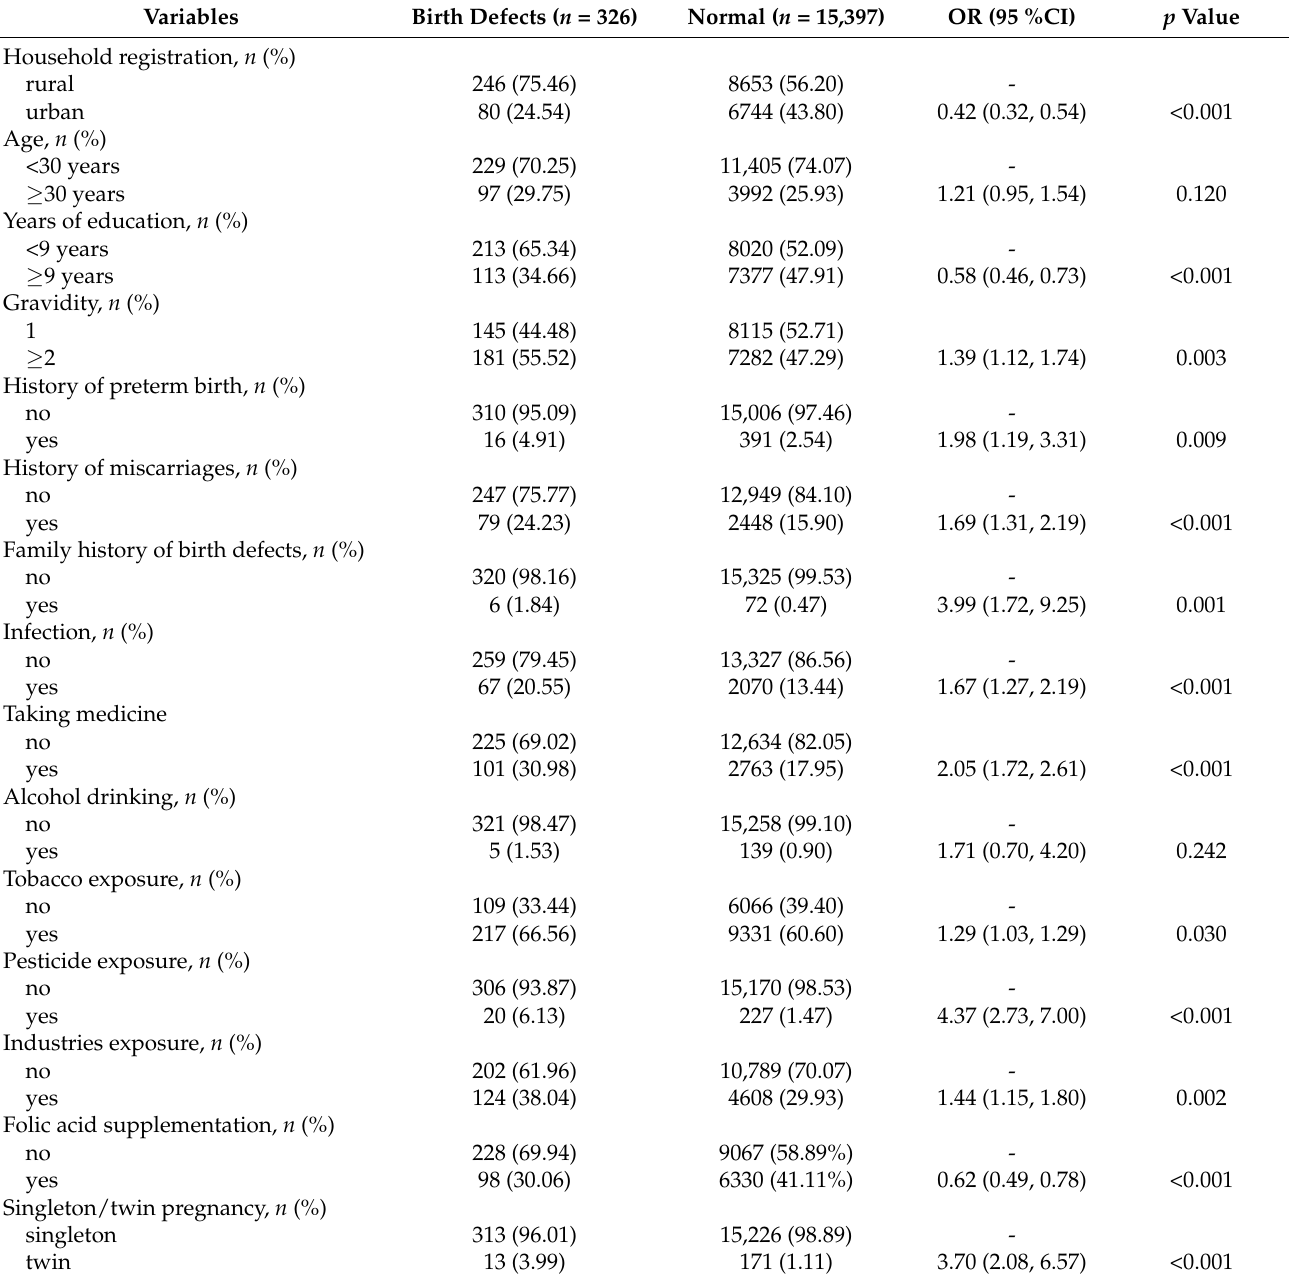
Table 2. Univariate logistic analysis of factors predicting birth defects in the training